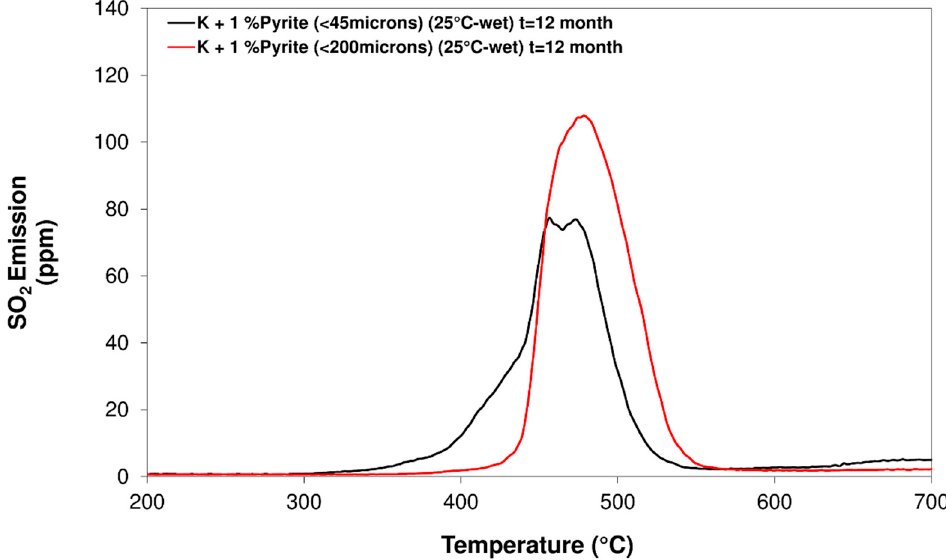
Figure 12. Comparison of the sulfur dioxide emissions of the coarse and fine fractions of pyrite (wet and dry environments at ambient temperature) .